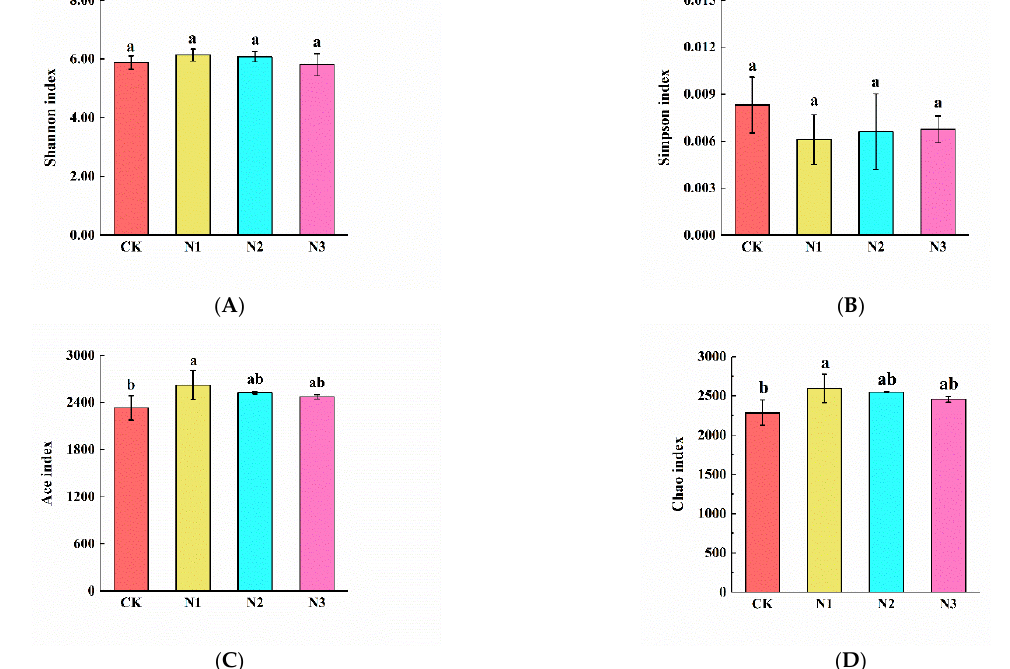
Figure 5. The alpha diversity of soil bacteria under nitrogen addition treatment. CK: 0 g N·m − 2 ·year − 1 ; N1: 6 g N·m − 2 ·year − 1 ; N2: 12 g N·m − 2 ·year − 1 ; N3: 24 g N·m − 2 ·year − 1 . ( A ): Shannon index; ( B ): Simpson index; ( C ): Ace index; ( D ): Chao index. Different letters indicate a significant difference among different concentrations of nitrogen addition treatments ( p < 0.05) as estimated by one-way ANOVA and the subsequent Duncan’s multiple-range test.